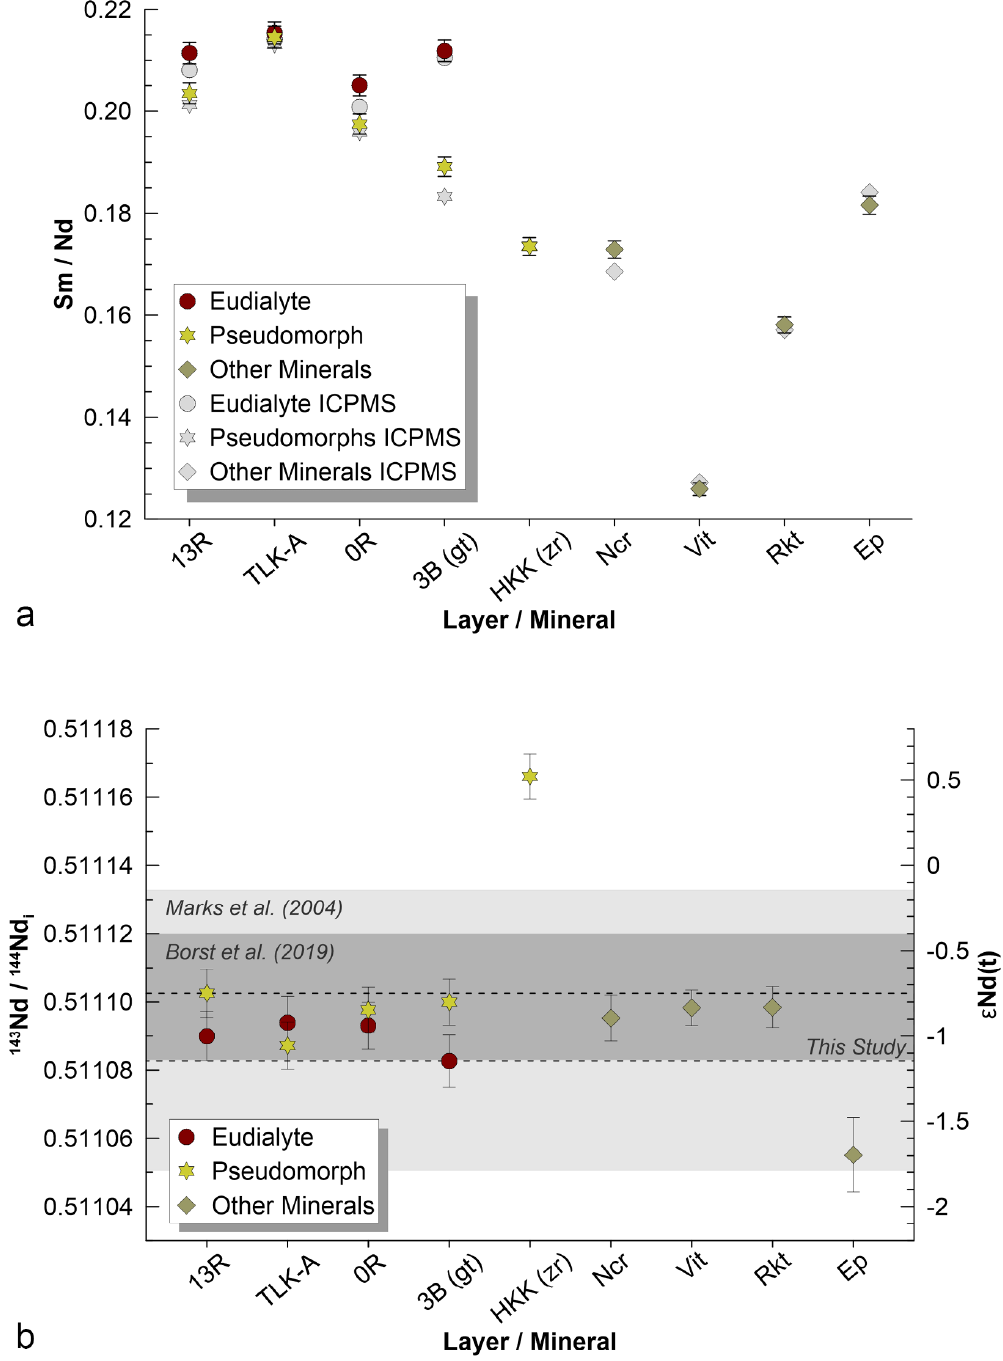
Figure 7. ( a ) Sm/Nd ratios for all samples calculated from TIMS data and compared to ICPMS data; ( b ) plot of initial Nd isotope ratios of fresh eudialyte, their pseudomorphs and other rare-earth-bearing minerals. Error bars are propagated double standard errors (2 σ ) on initial Nd ratios. Most data from the present study occupy a narrow range (dashed lines, excluding two outliers, see discussion). Shown for comparison are initial Nd ratios reported by Borst et al. [42] for whole rocks and mineral separates from kakortokite unit 0 (TIMS + ICPMS, dark grey box) and by Marks et al. [51] for mineral separates and one whole rock from a range of Ilímaussaq samples including an augite syenite, lujavrite and a naujaite (TIMS, light grey box). HKK = hybrid kakortokite, mineral abbreviations as in Table 4